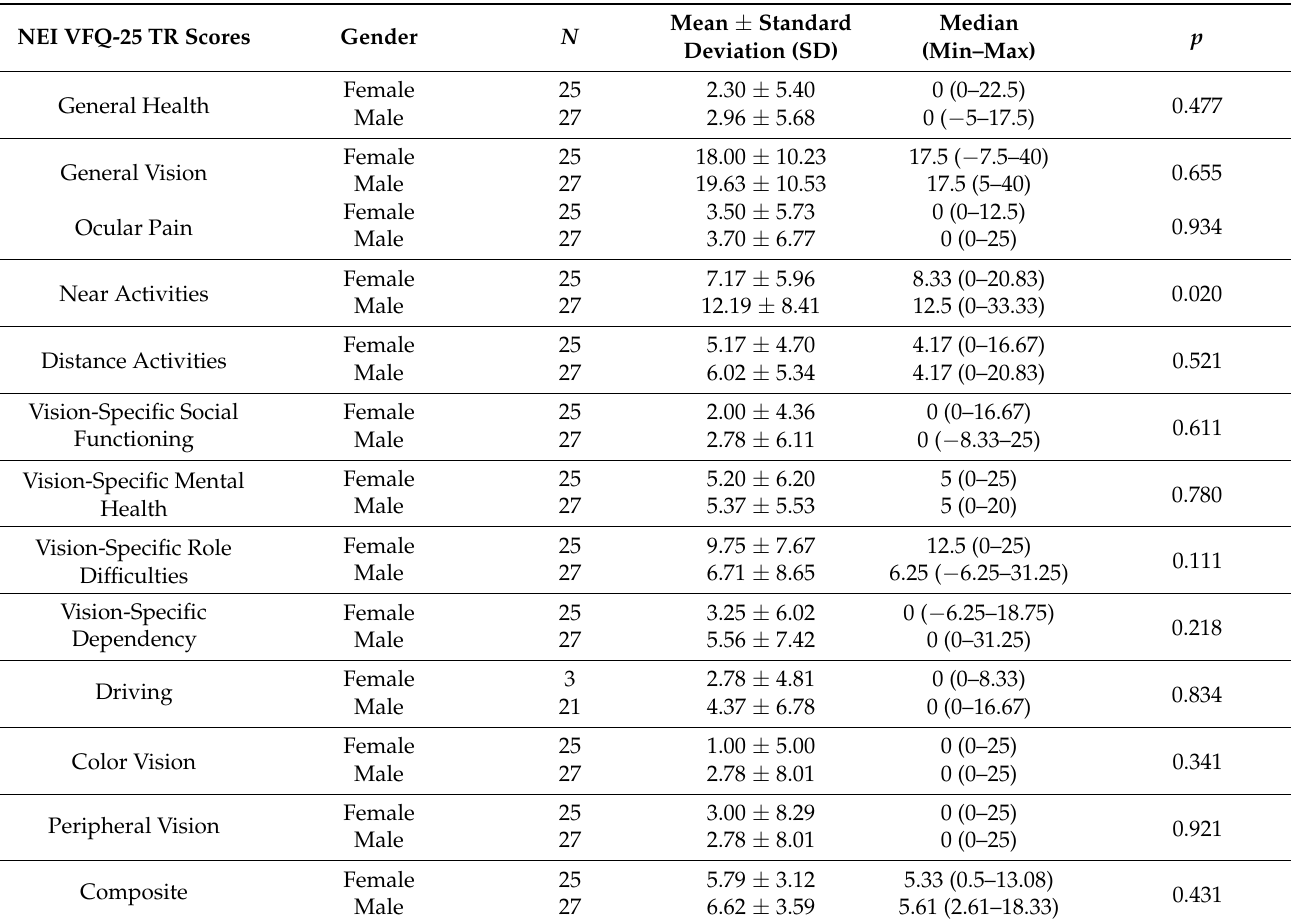
Table 4. Summary of the changes in NEI VFQ-25 TR subscale and composite scores after treatment (1 month after the third injection) according to gender.